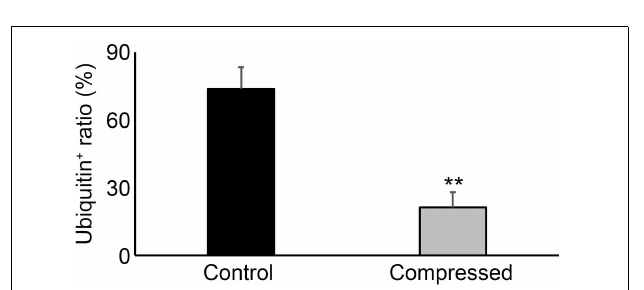
(A) control; (B) compressed neck skin. Original magnification, × 200; inset, × 400.